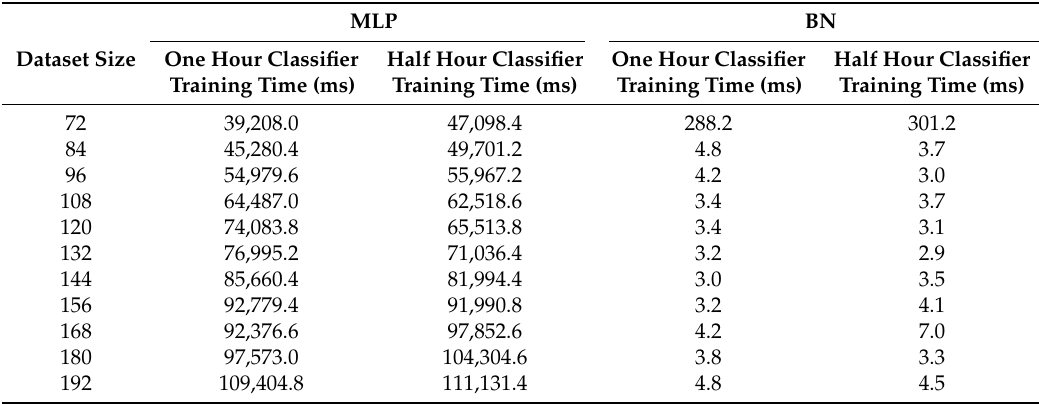
Table 5. Performance of situation prediction classifiers during